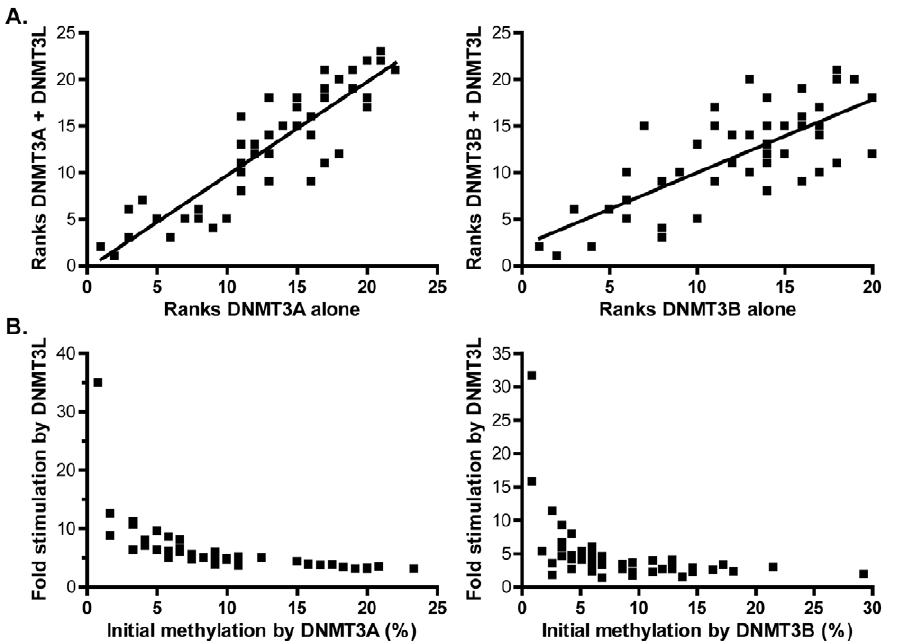
Figure 8. DNMT3L modulates DNA methylation pattern formation by DNMT3A or DNMT3B. A. Methylation ranks observed for DNMT3A alone (left) or DNMT3B alone (right) on the pBR322 top strand region are plotted against the corresponding methylation ranks observed when DNMT3L is also introduced (dcm 2 strands only). A clear correlation is observed, indicating that the overall hierarchy of sites is not changed (r 2 values are 0.80 for DNMT3A (left) and 0.55 for DNMT3B (right)). B. Fold stimulation exerted by DNMT3L at each individual site is plotted as a function of each site’s corresponding methylation efficiency in the absence of DNMT3L. The sites with the lowest initial methylation in the absence of DNMT3L clearly show the strongest stimulation, leading to the formation of more uniform DNA methylation patterns.